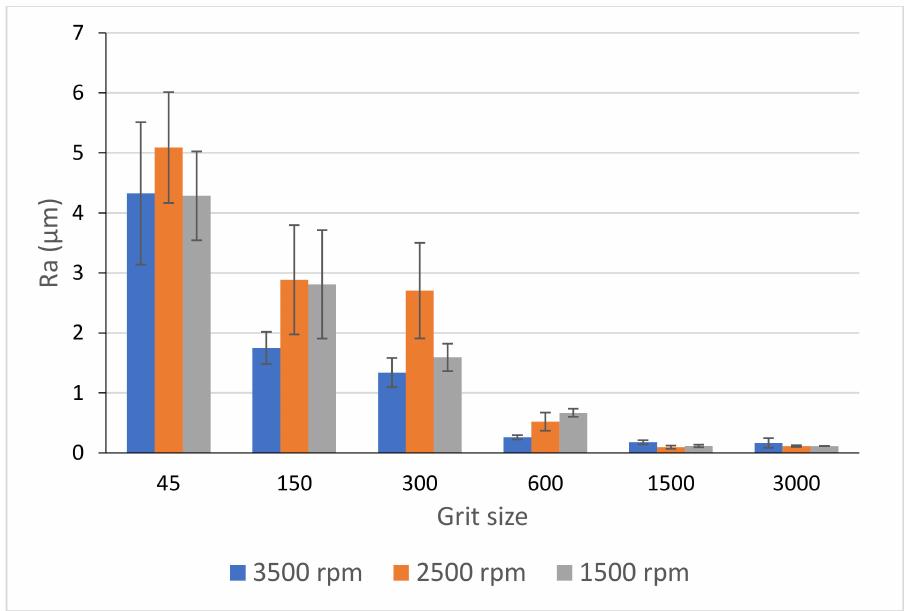
Figure 26. Ra-values of black granite depending on the grit size for different rotational speeds and fixed feed rate f = 1000 mm/min.